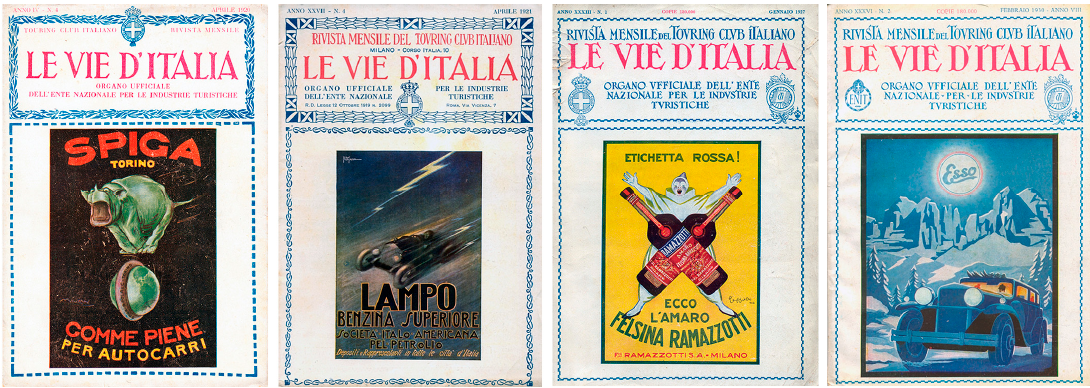
Figure 5. The search of recognizable graphics: the changes to the covers in April 1920, in April 1921, in April 1920, January 1927 and February